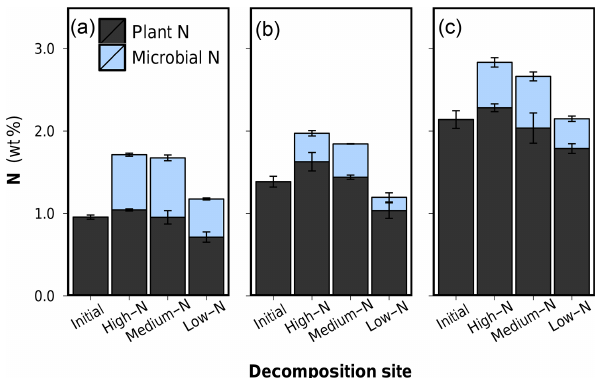
Figure 6. Microbial N content and plant N content in leaf litter after 75d of anaerobic decomposition in three substrates of varying N content (decomposition site). (a) Low-N leaf litter, (b) medium-N leaf litter, and (c) high-N leaf litter. Error bars represent standard deviations of three replicate